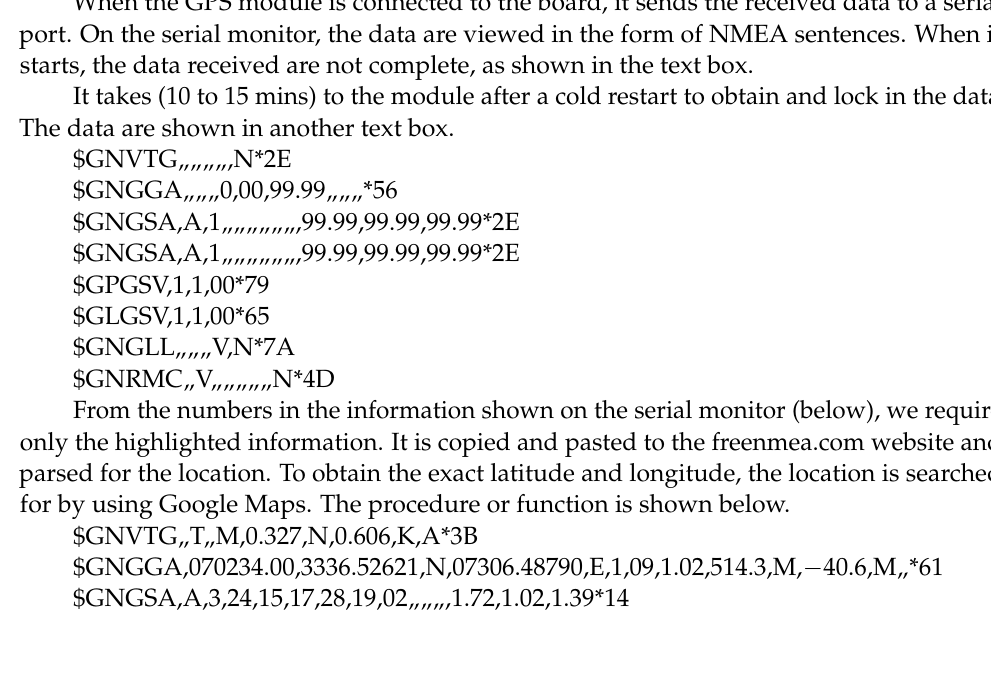
only the highlighted information. It is copied and pasted to the freenmea.com website and parsed for the location. To obtain the exact latitude and longitude, the location is searched for by using Google Maps. The procedure or function is shown